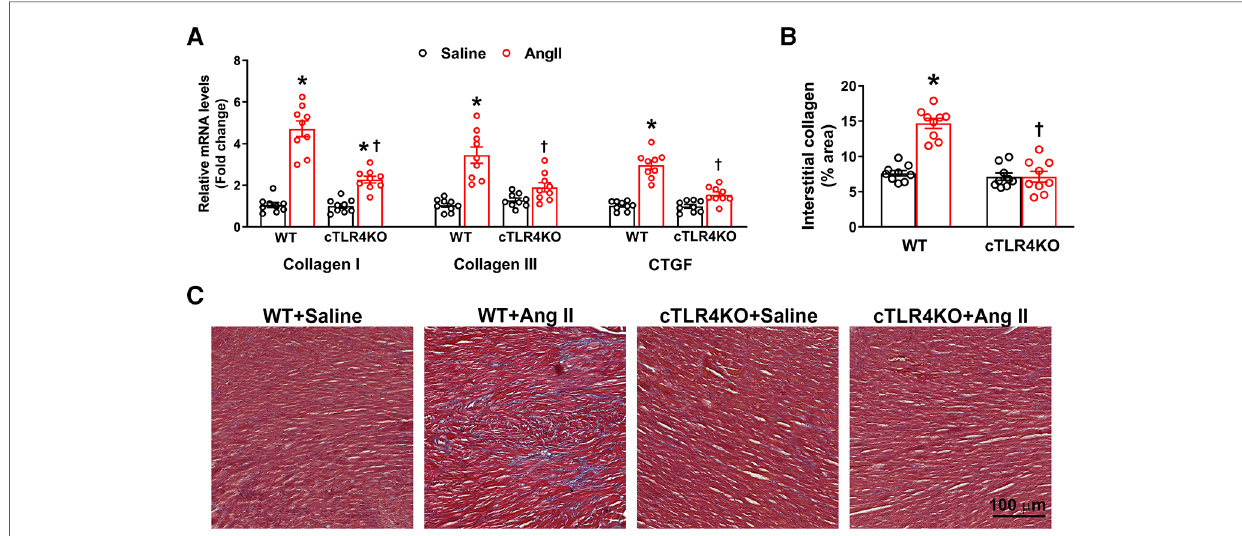
FIGURE 4 Cardiac-speci fi c TLR4 deletion attenuates angiotensin II-induced cardiac fi brosis. ( A ) Gene expression of pro fi brotic markers (Collagen I, Collagen III, and CTGF) in the left ventricle tissue was measured using real time RT-PCR. Increased pro fi brotic gene expression was observed in hypertensive WT mice, but this increase was attenuated in cTLR4KO mice with Ang II-infusion. ( B ) Changes in collagen deposition leading cardiac fi brosis was analyzed by Masson ’ s Trichrome staining. Mean interstitial collagen content in the left ventricular sections indicate an increased fi brosis in WT mice infused with Ang II. This increase in collagen deposition in the heart was attenuated in cTLR4KO mice receiving Ang II infusion. ( n =3 mice/group, Two-way ANOVA, * p <0.05 vs. WT+Saline, † p <0.05 vs. WT+Ang II). ( C ) Representative images of left ventricle sections stained with Masson ’ s Trichrome staining indicating collagen fi bers (blue in